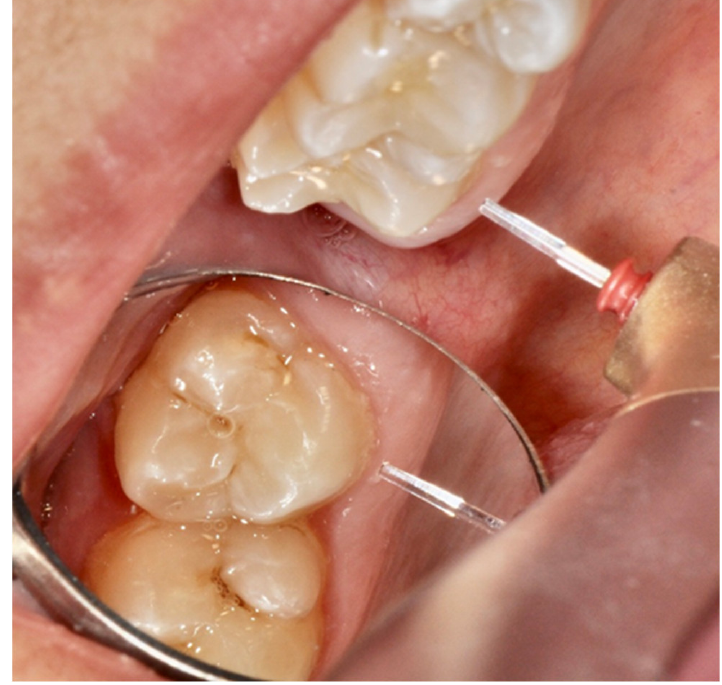
Figure 3. Example of the tip kept at 1 mm of distance from the tooth neck as in the turtle technique.